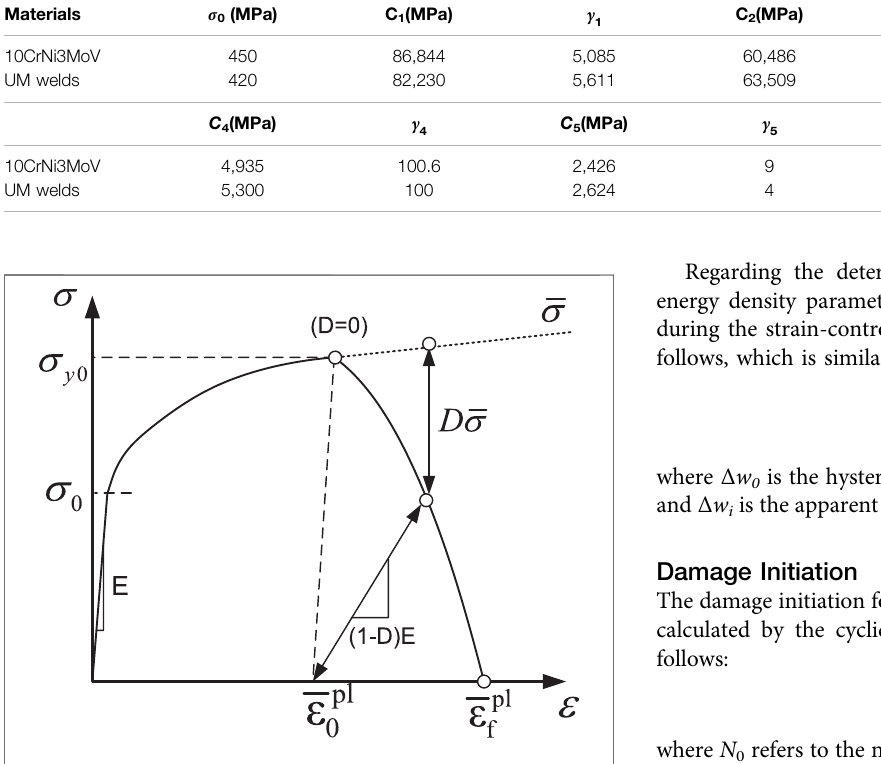
FIGURE4| Damageevolutionduringmaterialfailure(Hormozietal.,2014).